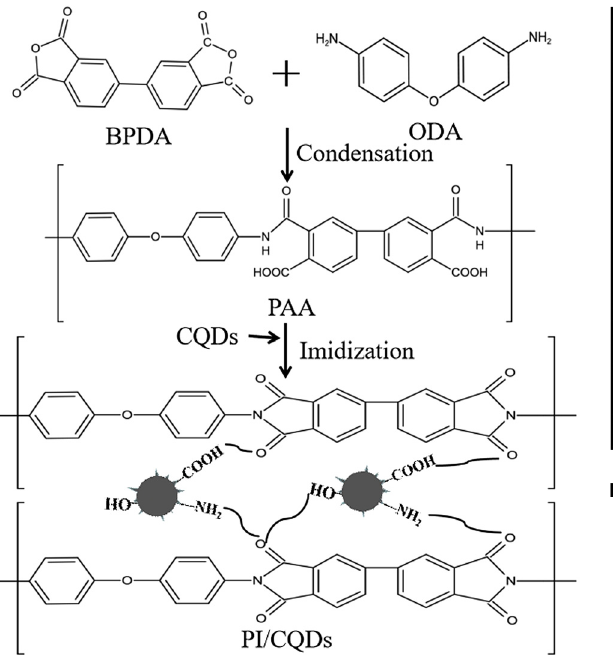
Figure 1: Schematic diagram of the preparations of PI/CQDs.